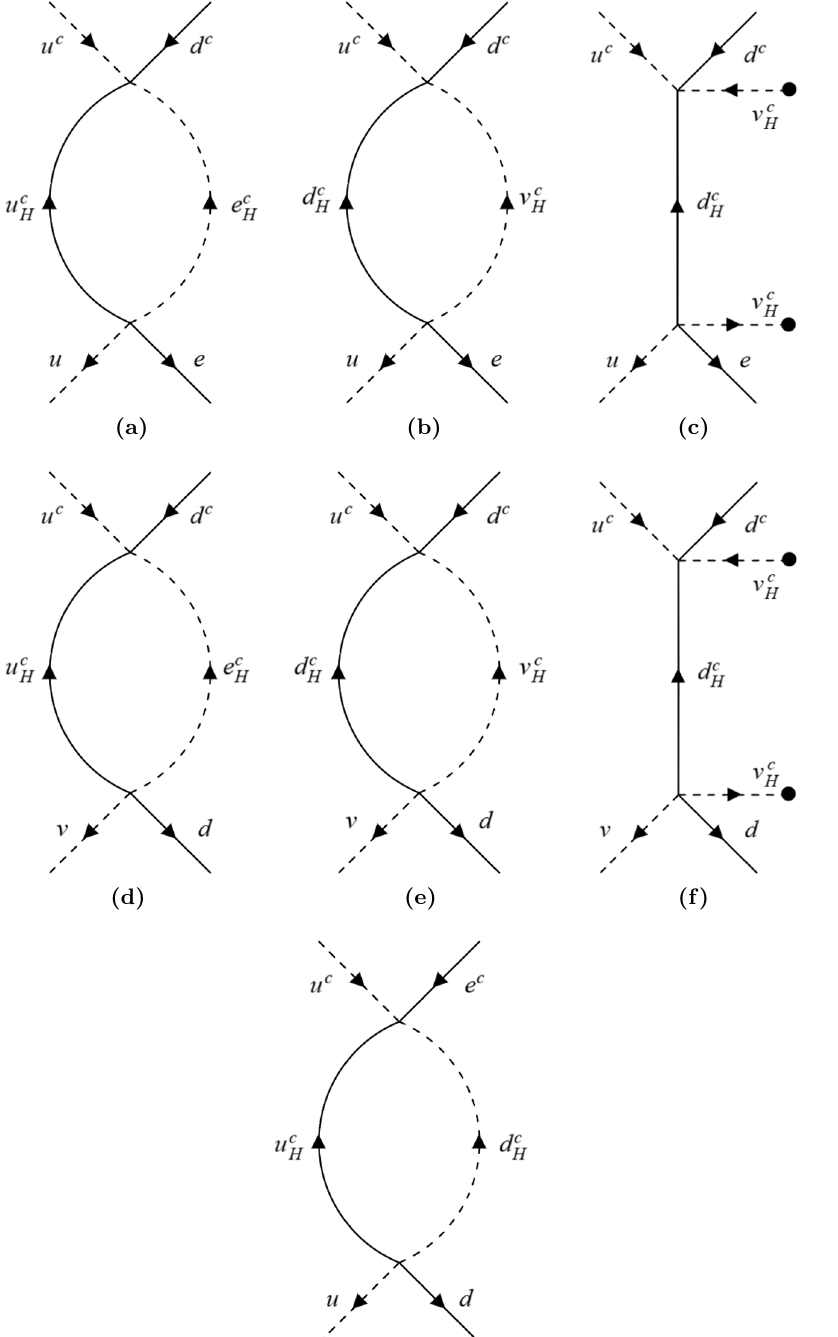
Figure 5. Dimension-(cid:12)ve proton decay diagrams. Dashed lines represent bosons, solid lines repre- sent fermions, and dots represent the vevs. These are graphs between the B -violating superpotential coupling F c F c H c H c and the B -conserving superpotential coupling FFH c H c .